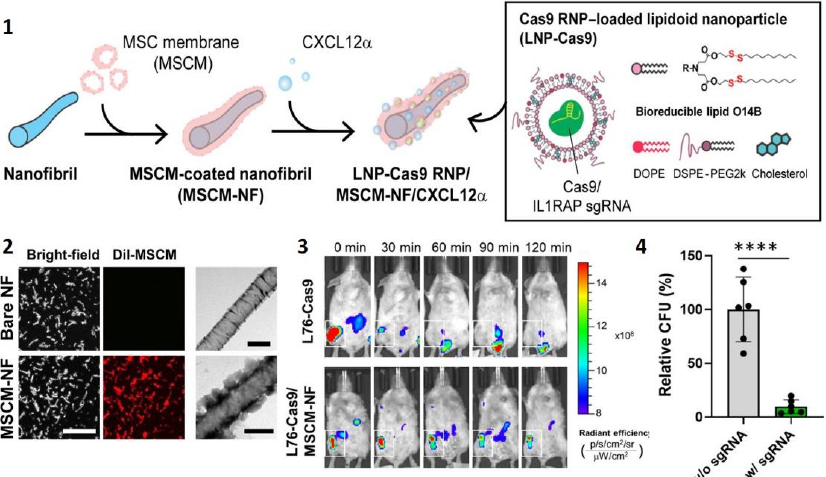
Figure 6. Injectable biomimetic nanofiber formulation for acute myeloid leukemia treatment: ( 1 ) PCL nanofibril coated with mesenchymal stem cell membrane (MSCM) loaded with cytokine CXCL12α and lipid nanoparticles-CRISPR/Cas9 (LNP-Cas9) complex. ( 2 ) Images of naked NF and MSCM-coated NF. ( 3 ) Biodistribution of MSCM-NF/LNP-Cas9 after injection into the bone marrow of right tibia indicates prolonged localization in tibia when compared with LNP-Cas9. ( 4 ) Leukemia stem cells exhibit reduced colony formation after treatment with therapeutic